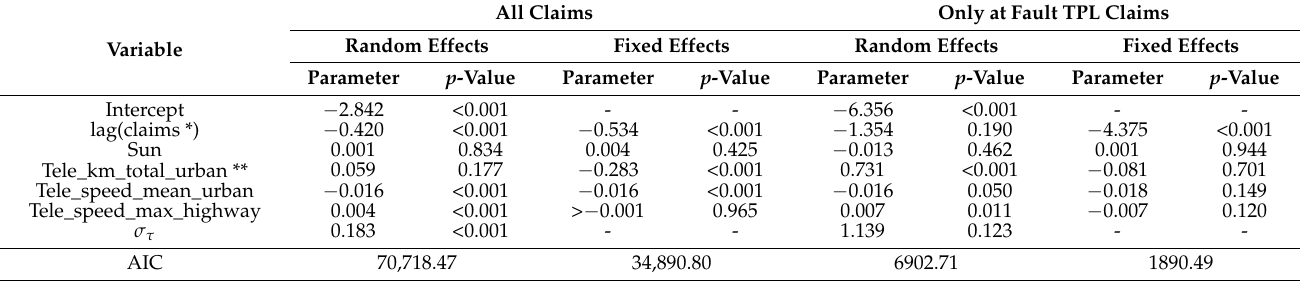
Table A8. Cross-table with the parameter estimates of random effects and fixed-effects Poisson panel data models, with p -values, for the total number of claims (left) and at-fault third party liability (TPL) claims (right) per month and per insured based on the eight observed months in 2018 and 2019, i.e., month 5 is included. The models consider the average number of sunshine hours per day as explanatory variable describing weather conditions.